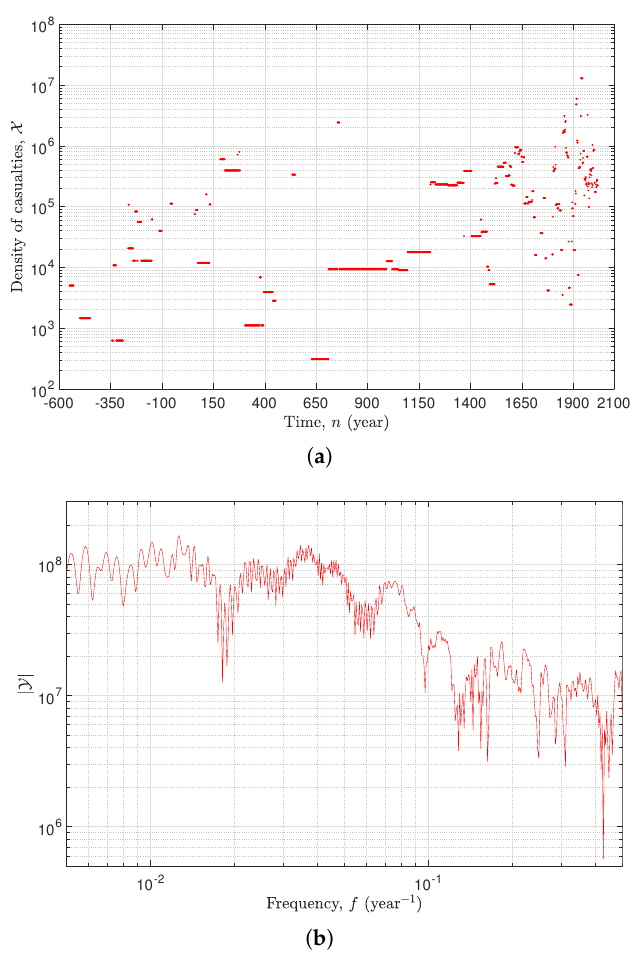
Figure 8. The density of casualties and its spectrum: ( a ) X ( n ) ; ( b ) |Y ( f ) | . Table 1. Values of the parameters { β 1 , β 2 , β 3 , β 4 } for the fitting models of H ( S ) , H